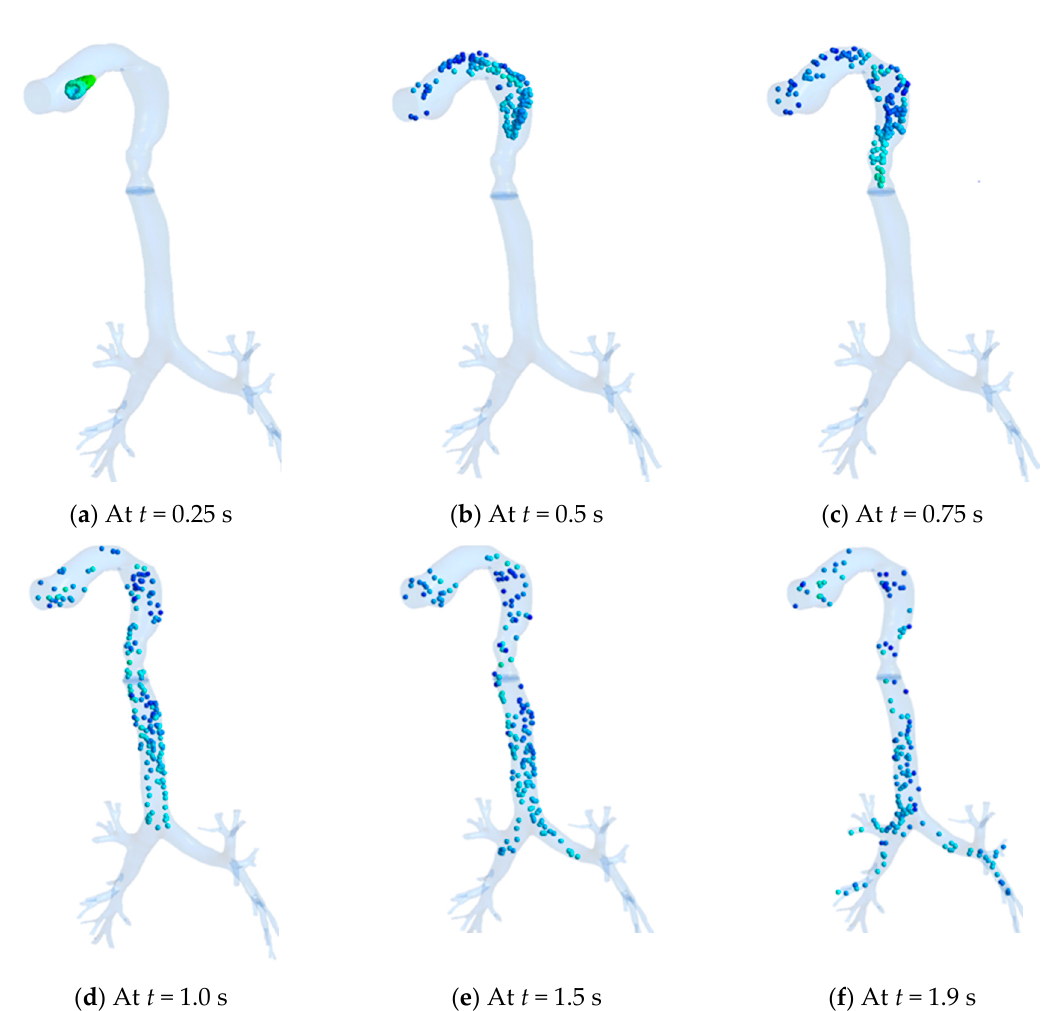
Figure 13. Propagation of toxic particles in HRT at various instants. ( a ) At t = 0.25 s; ( b ) At t = 0.5 s; ( c ) At t = 0.75 s; ( d ) At t = 1.0 s; ( e ) At t = 1.5 s; ( f ) At t = 1.9